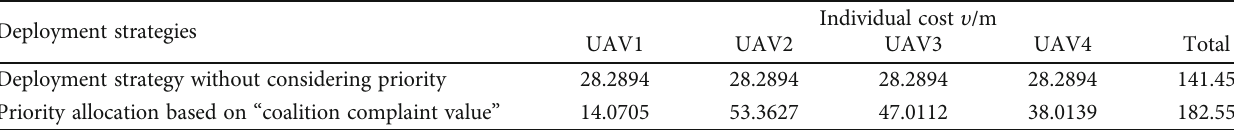
Table 4: Individual payment costs of the two UAV priority allocation